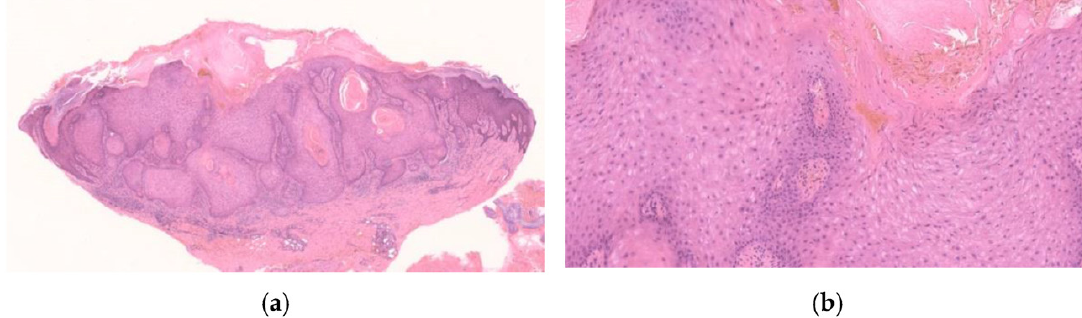
Figure 1. Histopathological findings of KA en plaque/nodule. Gross findings of the lesion reveal an exo-endophytic and non-crateriform architecture ( a ). The lesion consisted of proliferation of large pale eosinophilic cells with a few layers of basophilic cells at their periphery ( b ). Large pale eosinophilic cells show no nuclear atypia ( b ).